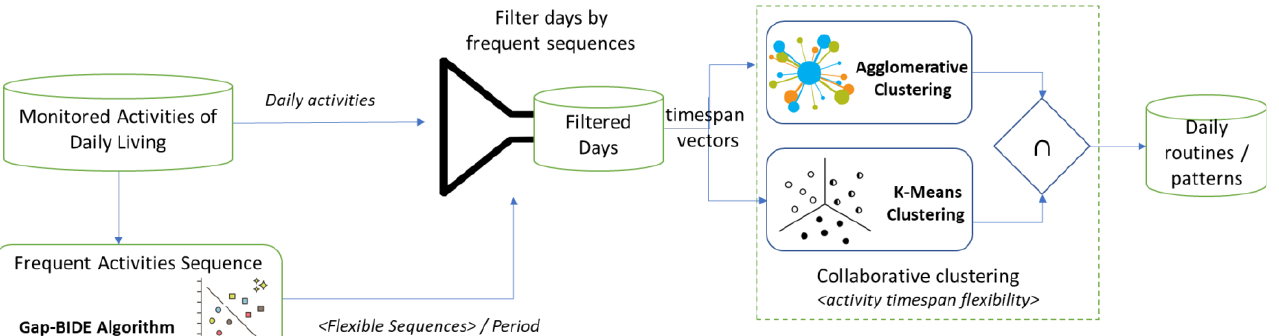
Figure 1. Daily routine identification considering flexibility aspects. Frequent activities are extracted with the Gap-BIDE algorithm while Collaborative Clustering is used to group and detect activity patterns. The identified clusters are represented in the graphs as geometric forms with different colors.